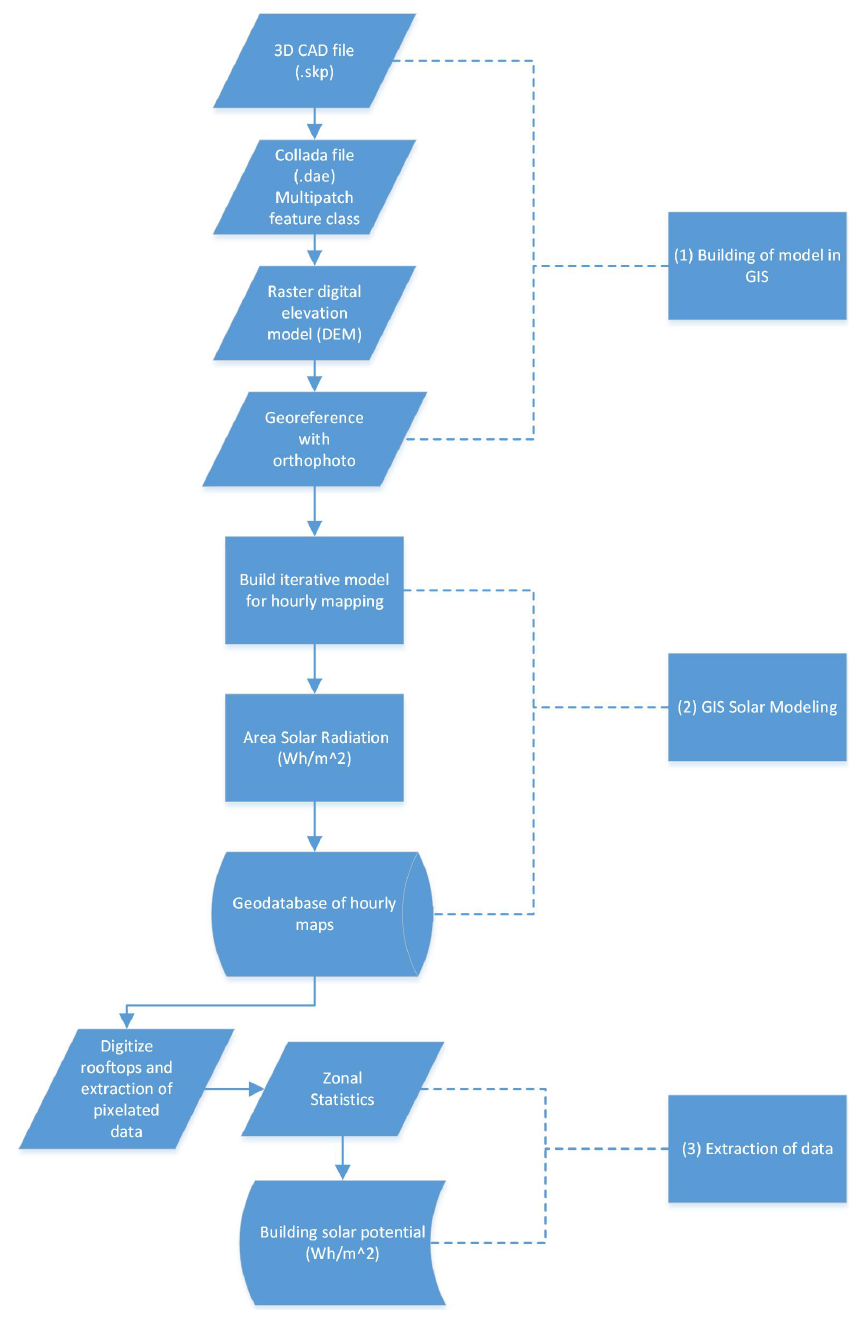
Figure 1. Methodology for GIS solar modeling of hourly solar